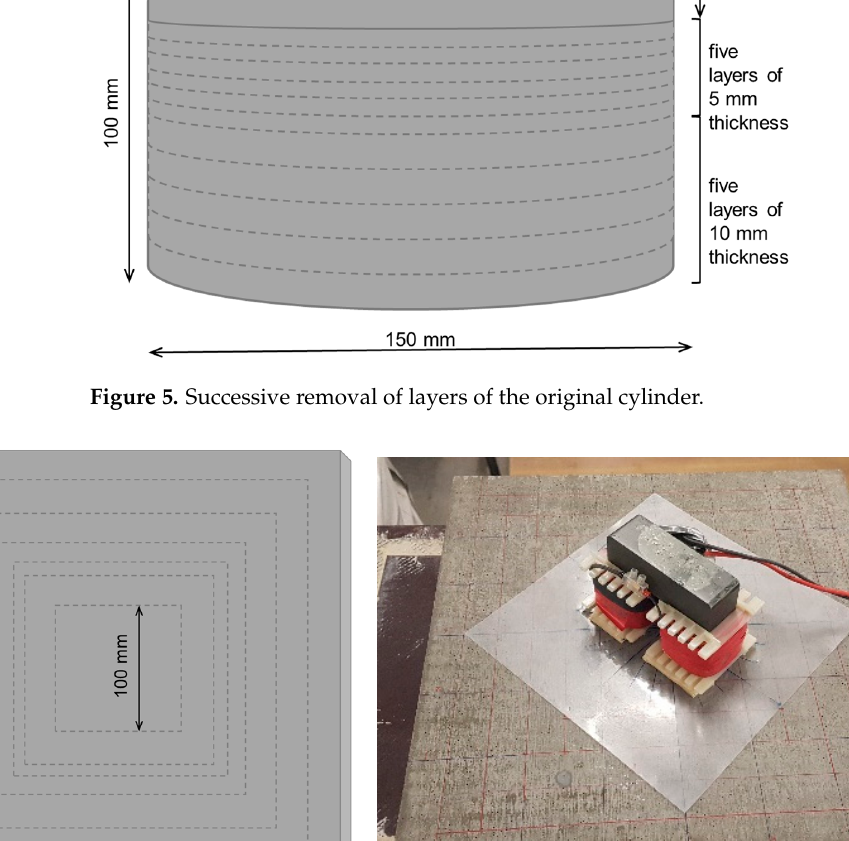
Figure 5. Successive removal of layers of the original cylinder.